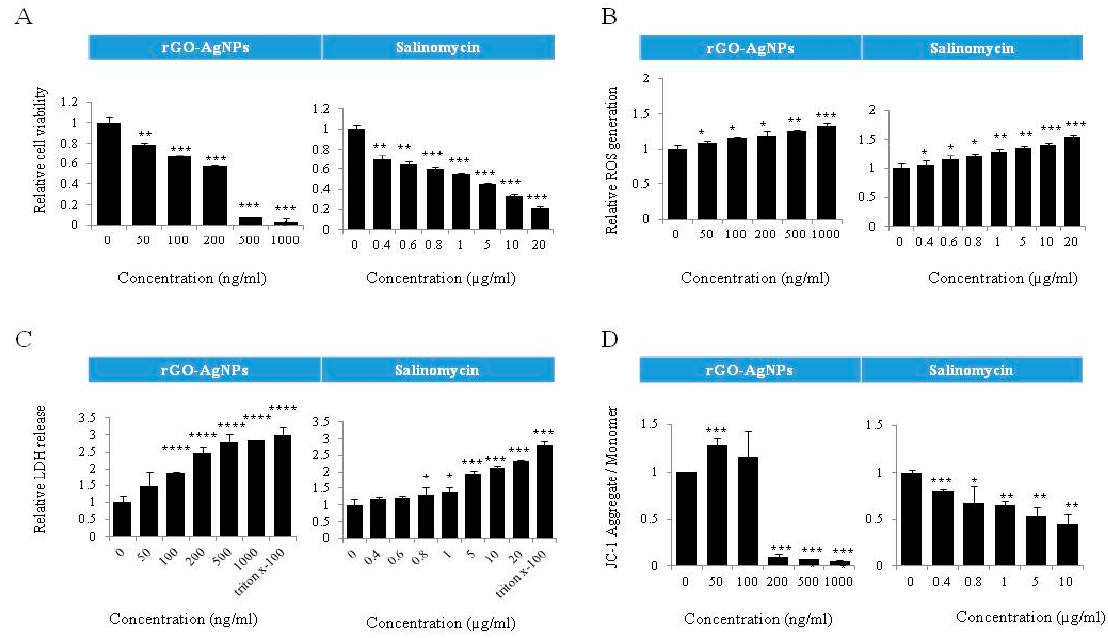
Figure 8. Dose-dependent effect of rGO–Ag and salinomcyin on cytotoxicity if ALDH + CD133 + cells. ALDH + CD133+ cells were treated with various concentrations of rGO–Ag and salinomycin for 24 h. Cell viability was determined using a cell counting kit (CCK-8) assay ( A ); reactive oxygen species (ROS) generation was determined by 2 ′ ,7 ′ -dichlorofluorescein diacetate (DCFDA) ( B ); lactate dehydrogenase (LDH) activity was measured at 490 nm using the LDH cytotoxicity kit ( C ); mitochondrial transmembrane potential (MTP) was determined using the cationic fluorescent indicator JC-1 ( D ). The results are expressed as the mean ± standard deviation of three independent experiments. The treated groups showed statistically significant differences from the control group according to Student’s t -test (* p < 0.05, ** p < 0.01, *** p < 0.005, **** p < 0.001).